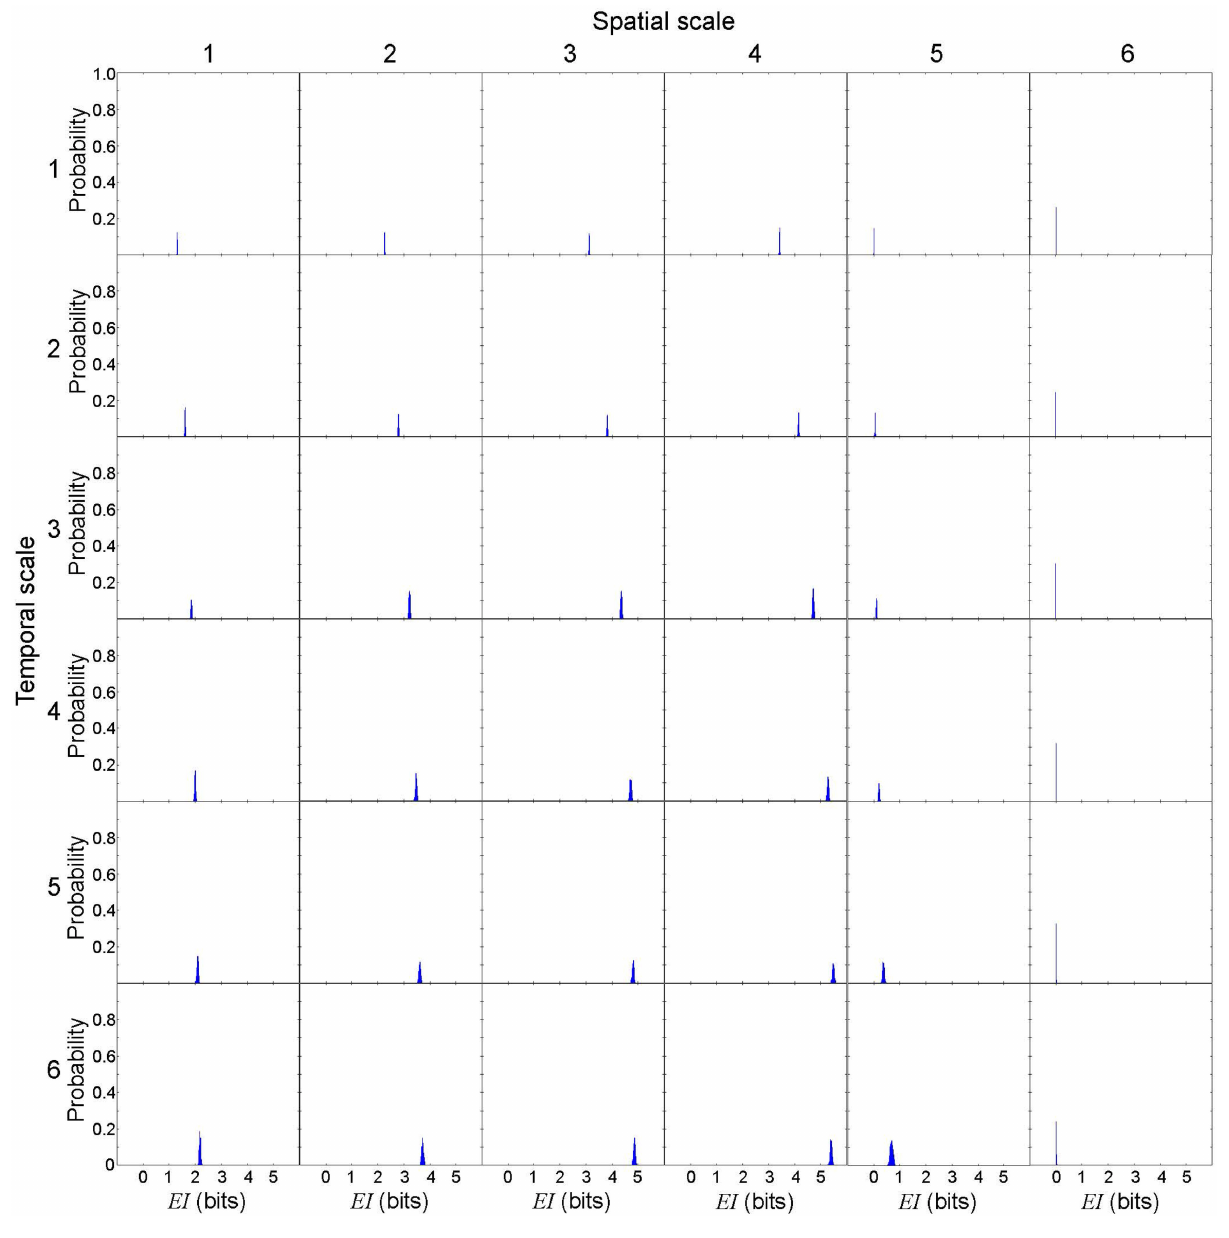
FIGURE 6 | Effective information from cause X to effect Y in a representative spiral wave data set. EI ( X → Y )[ = I ( X ; Y ) = H ( X ) + H ( Y ) − H ( X , Y )] is not uniquely determined due to the discretization effect, but the variance is small. Each subplot represents the probability distribution of EI ( X → Y ). The columns represent the spatial scales (1 through 6) and the rows represent the temporal scales (1 through